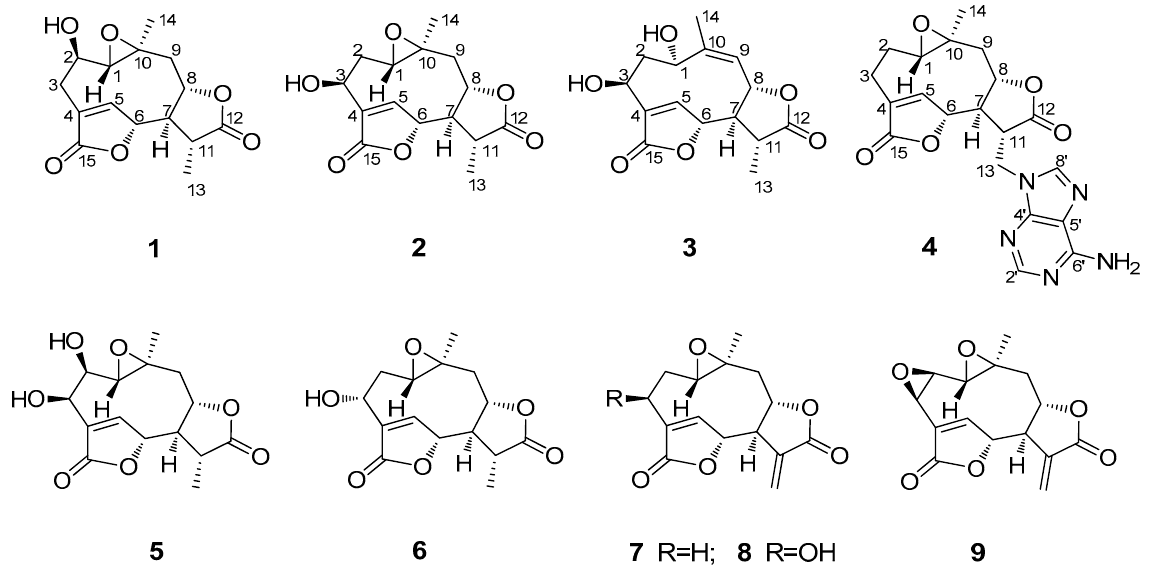
Figure 1. Chemical structures of compounds 1 − 9.